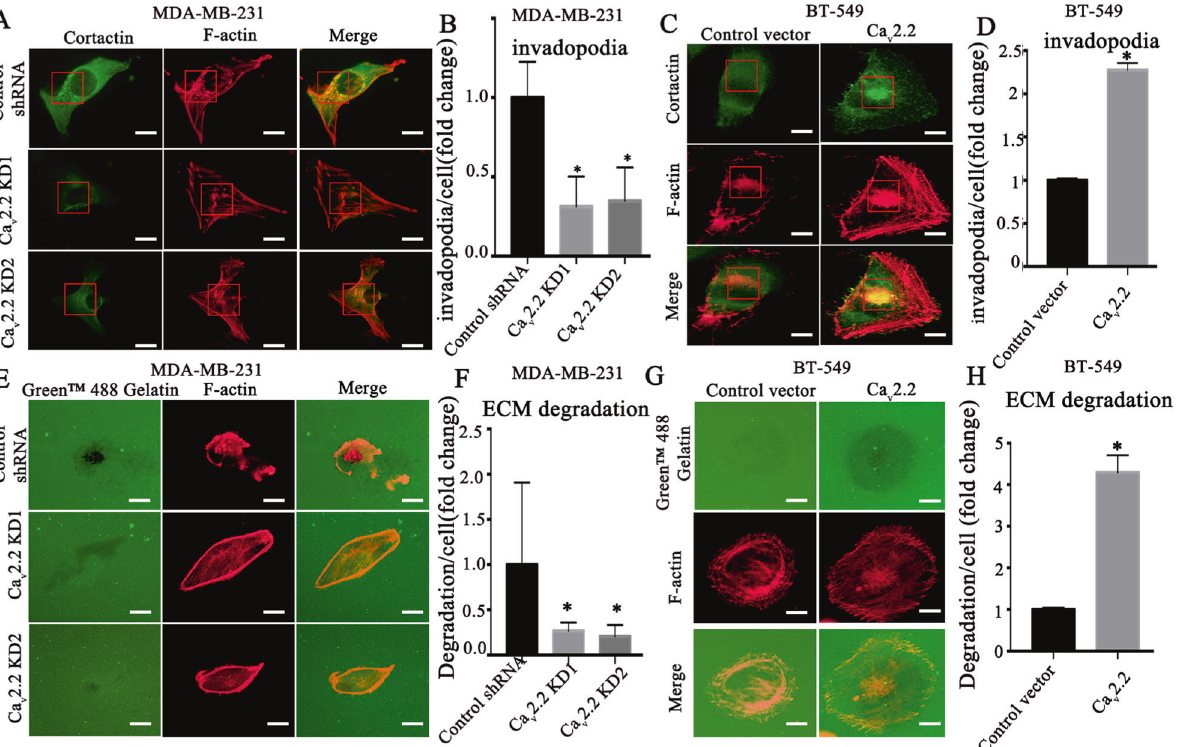
Fig. 3 Cav2.2 promotes invadopodia formation and ECM degradation. A Human breast cancer MDA-MB-231 cells stably expressing Ca v 2.2 shRNA or control shRNA were subjected to invadopodia formation assay. Invadopodia were visualized by co-localization of cortactin (green) and F-actin puncta (red). Representative images were shown. Bars: 5 μ m. B Quanti fi cation of invadopodia in MDA-MB-231 cells. P value was determined using Student ’ s t-test (* p < 0.01). Error bars represent mean ± s.d. C Human breast cancer BT-549 cells transfected with Ca v 2.2 cDNA or a control vector were subjected to invadopodia formation assay. Invadopodia were visualized by co-localization of cortactin (green) and F-actin puncta (red). Representative images were shown. Bars: 5 μ m. D Quanti fi cation of invadopodia in BT-549 cells. P value was determined using Student ’ s t-test (* p < 0.01). Error bars represent mean ± sd. E MDA-MB-231 cells stably expressing Ca v 2.2 shRNAs or